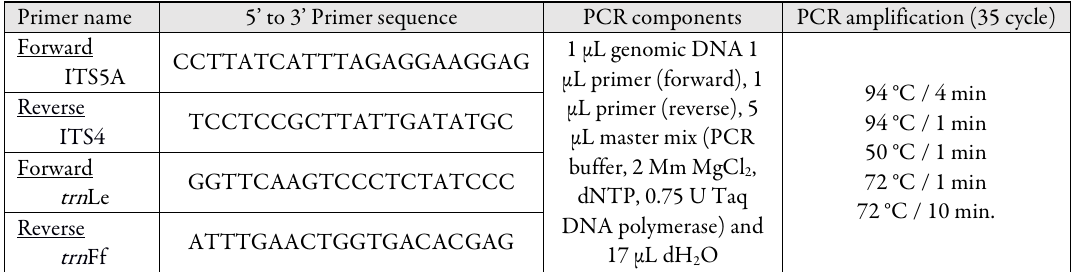
Table 2. nrITS and cpDNA trn L-F primers and PCR components used for PCR